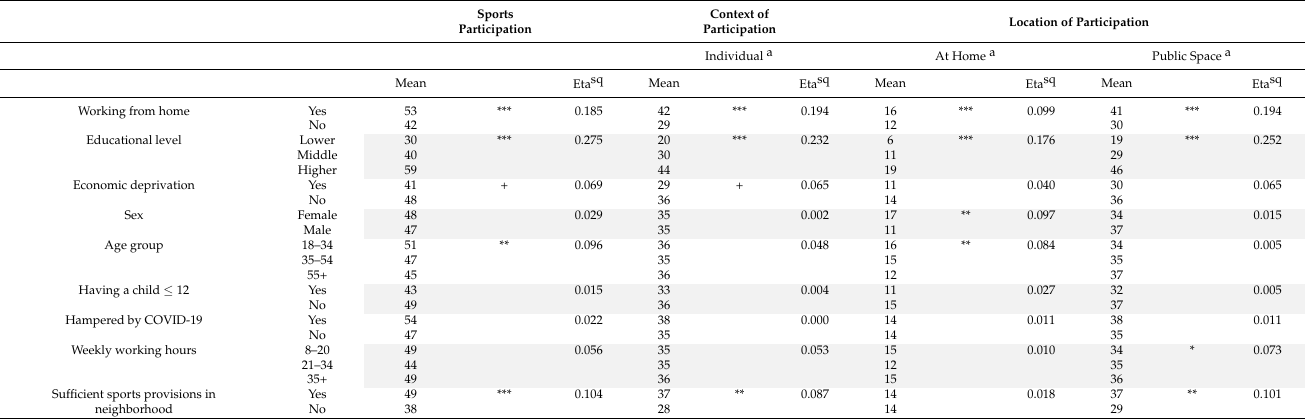
Table 3. Adjusted predicted mean MCA estimates in percentages and adjusted ANOVA signifi- cance